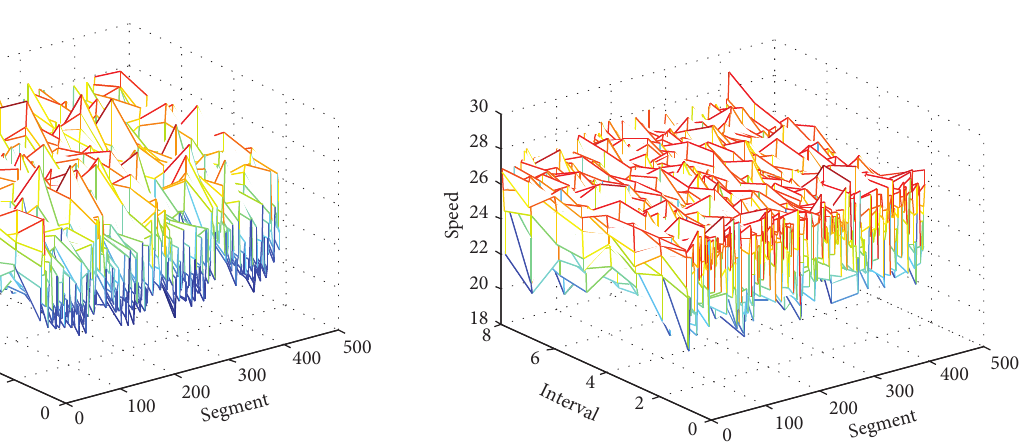
Figure 6: Flow on each segment per interval when demand is 3.